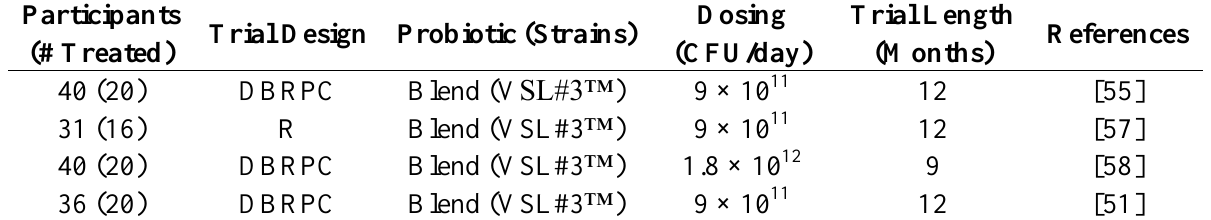
Table 3. Randomized trials of probiotics in prevention of onset or recurrence of pouchitis.